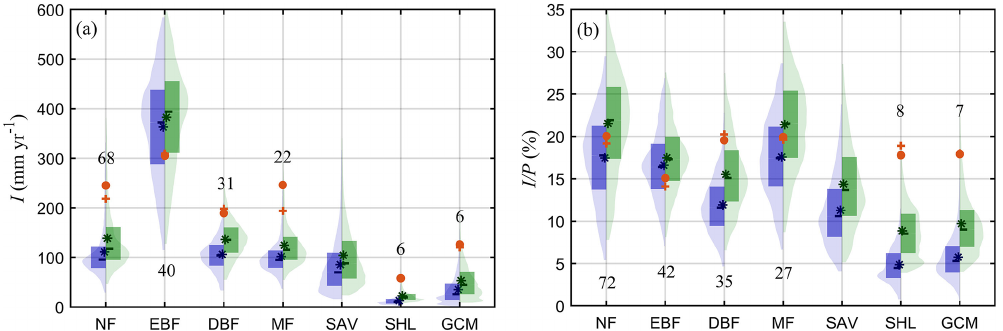
Figure 7. Violin plots of I over different land-use types across the globe. (a) I (in mmyr − 1 ) and (b) I/P (in %). Blue violin limbs show estimates per squared metre of land surface and green per square metre of canopy cover. The red circle and cross represent the mean and median values from field campaigns. The label in each column represents the number of field observations. Land-use types are based on the IGBP classification of MCD12C1 corresponding to 2001, including evergreen needleleaf forests and deciduous needleleaf forests (NF), evergreen broadleaf forests (EBF), deciduous broadleaf forests (DBF), mixed forests (MF), woody savannas and savannas (SAV), closed shrublands and open shrublands (SHL), and grasslands, croplands and cropland/natural vegetation mosaics